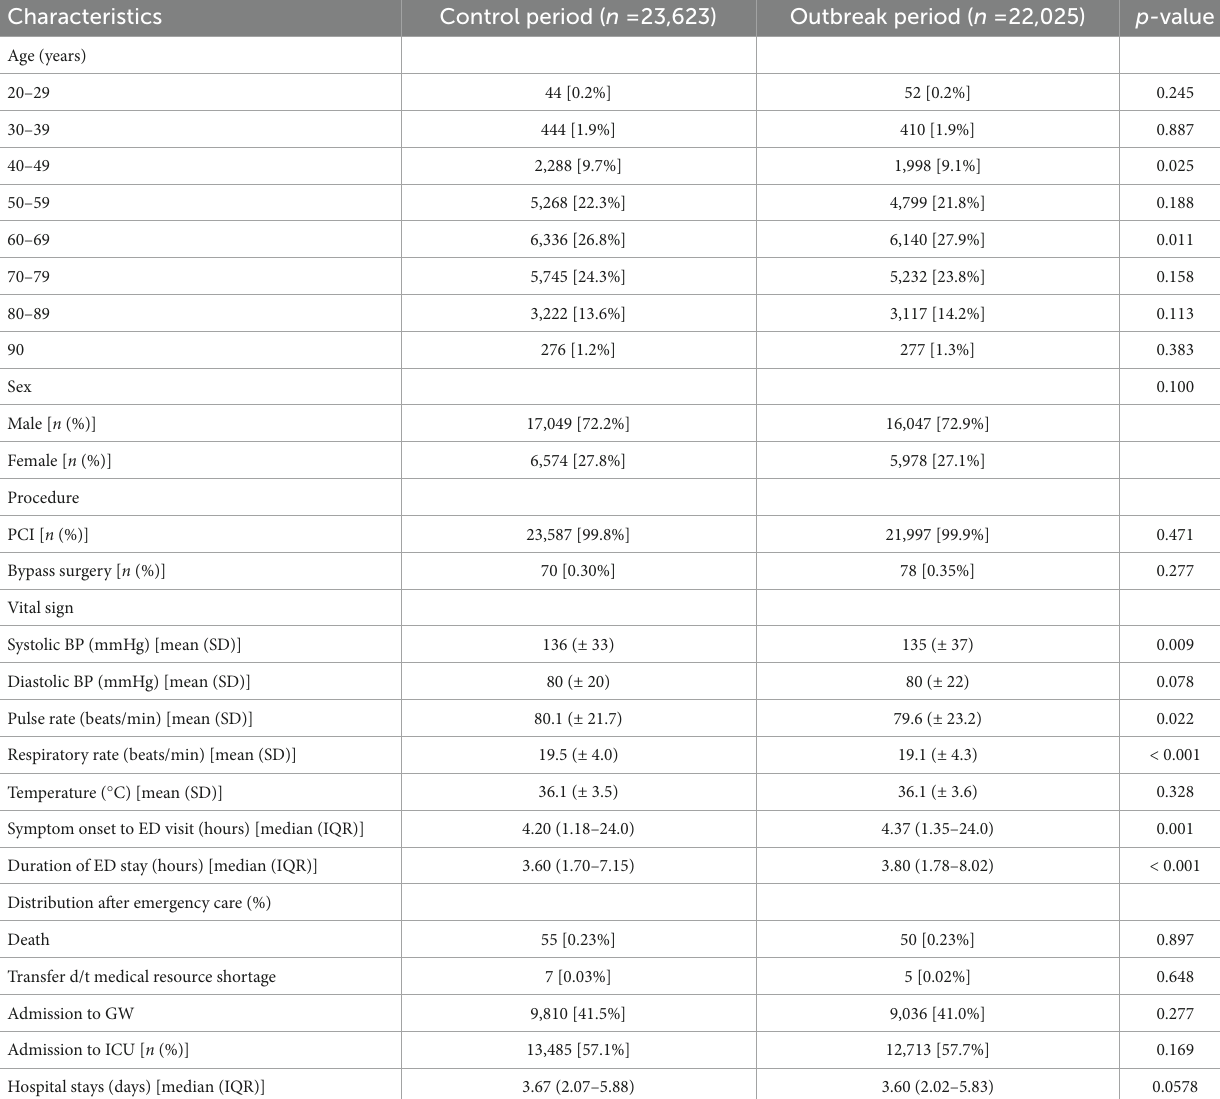
TABLE 1 Baseline clinical characteristics of patients with AMI during the control and the outbreak periods. Characteristics